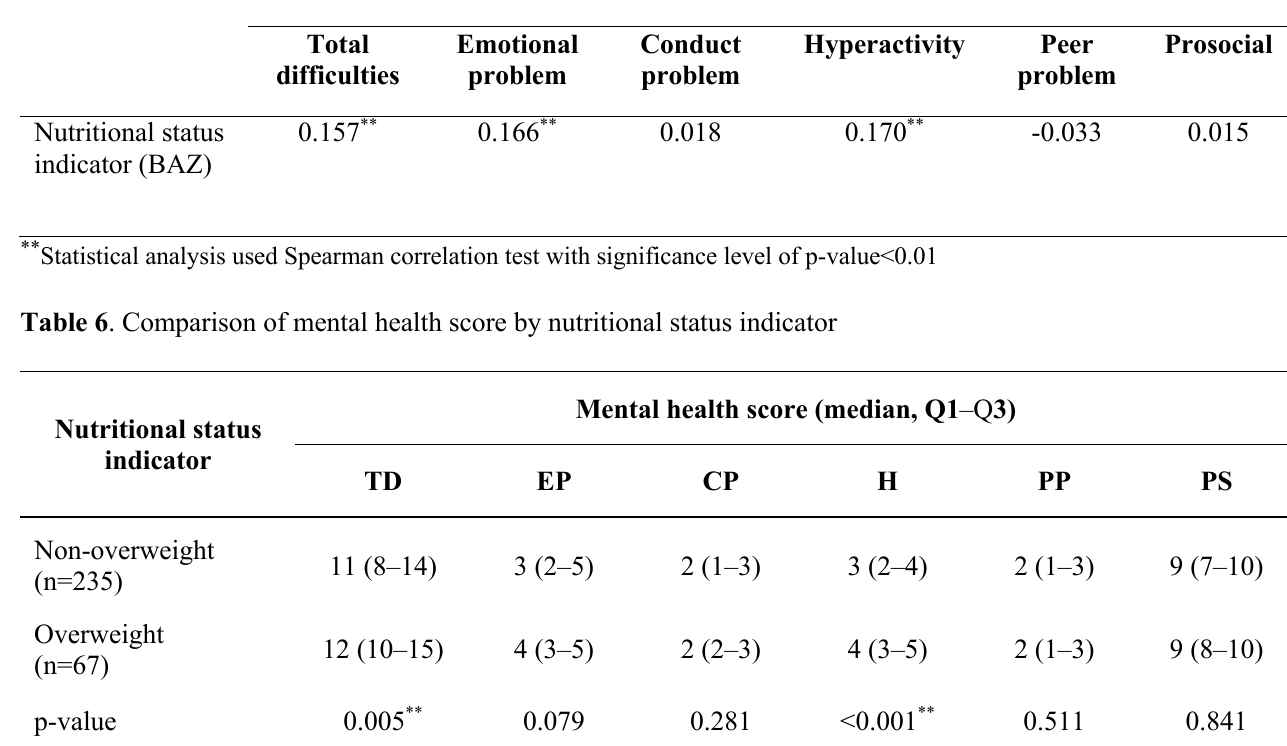
Table 5 . Correlation between nutritional status indicator and mental health score (n=302) Variable